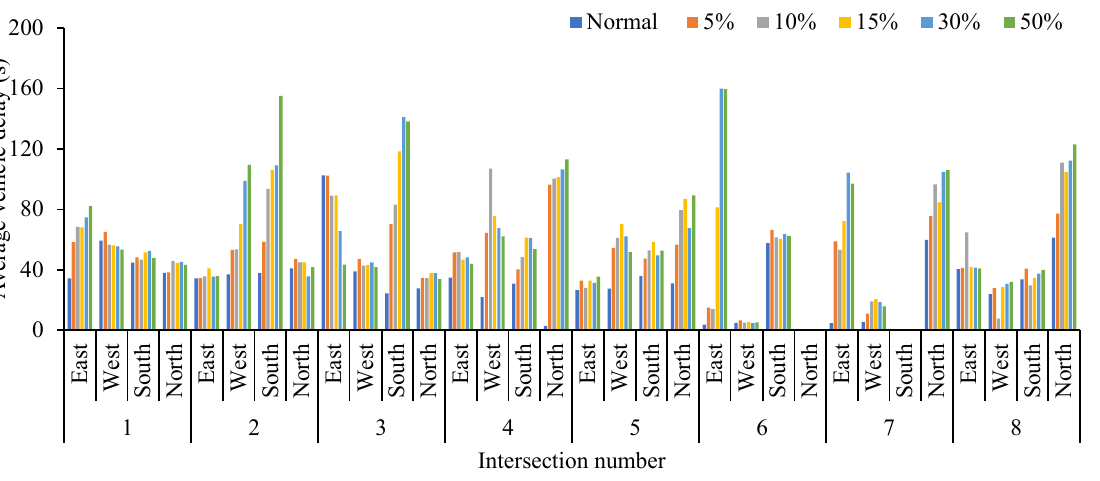
Figure 8. Comparison of average vehicle delay at different intersections.